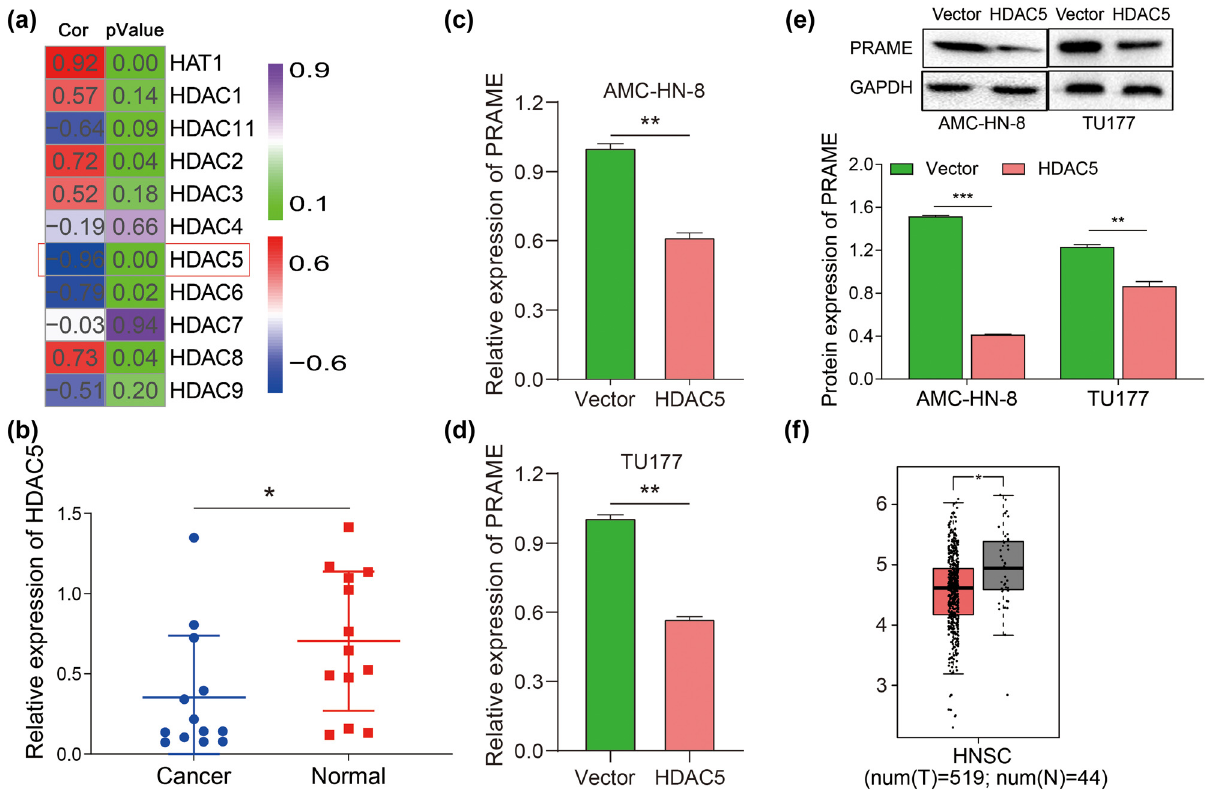
Figure 4: HDAC5 is underexpressed and negatively correlated with PRAME in LSCC. ( a ) HDAC5, as an important epigenetic regulator, was selected through the microarray analysis and was negatively correlated with PRAME. ( b ) HDAC5 expression was markedly downregulated, compared with corresponding normal tissues via qRT - PCR. ( c ) PRAME expression was signi fi cantly downregulated in AMC - HN - 8 treated with overexpressed HDAC5 via qRT - PCR. ( d ) PRAME expression was signi fi cantly downregulated in TU177 treated with overexpressed HDAC5 via qRT - PCR. ( e ) The protein expression of PRAME was signi fi cantly reduced in AMC - HN - 8 and TU177 cells treated with overexpressed HDAC5 by means of western blot assay. ( f ) The expression of HDAC5 were signi fi cantly lower in HNSC, compared with paired non - tumor tissues, cited from GEPIA ( * P < 0.05, ** P < 0.01, *** P < 0.001 )